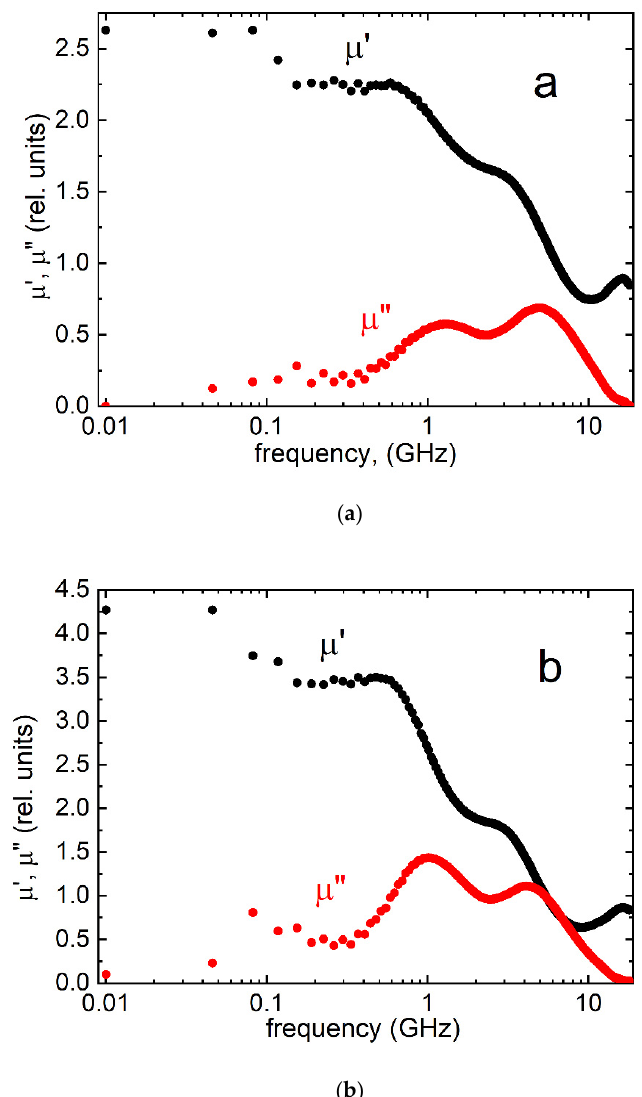
Figure 7. Complex permeability spectra of sample N1 ( a ) and sample N2 ( b ). Black dots are the real part of the permeability; red dots are the imaginary part of the permeability.